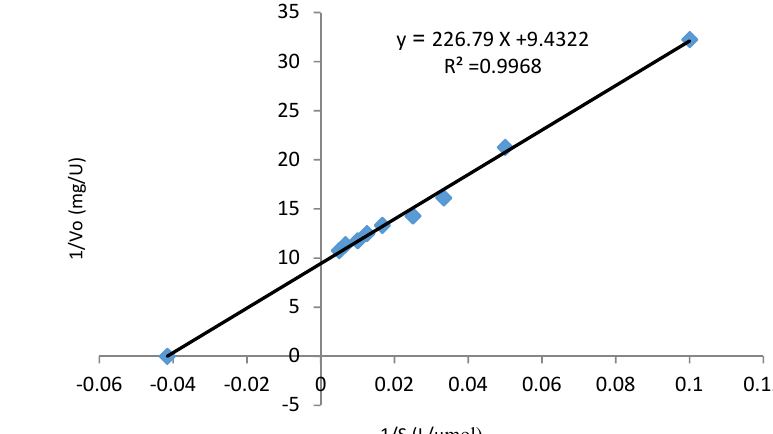
Fig. 3: merA amino acid sequence-based neighbor-joining tree y = 226.79 X +9.4322 R² =0.9968